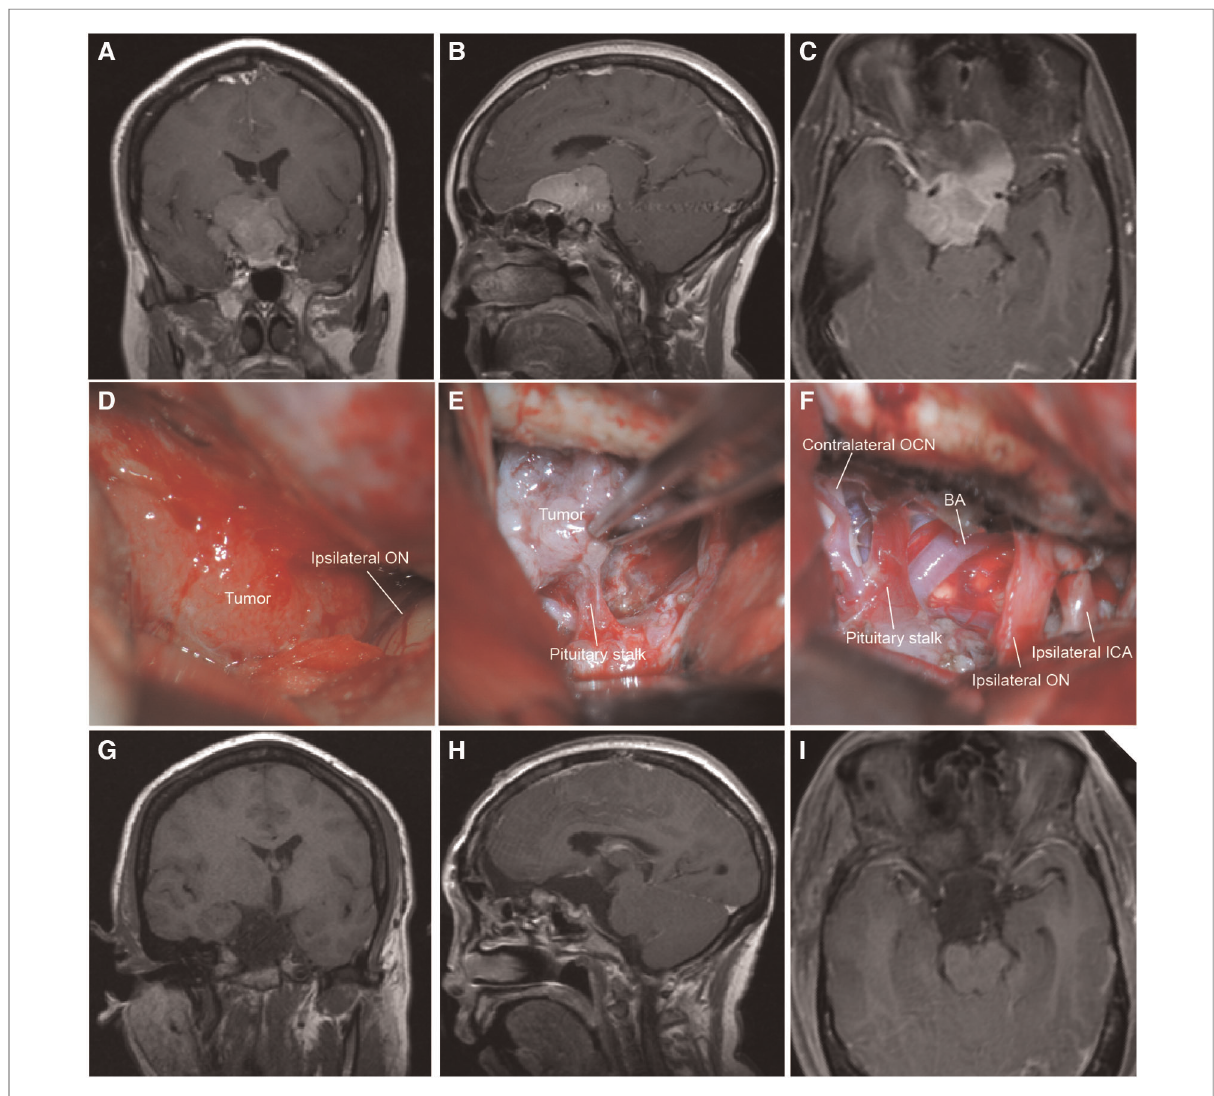
FIGURE 2 The MRI and intraoperative view of a patient operated with the unilateral subfrontal approach. ( A – C ) Preoperative T1-weighted MRI scan showing the giant TSM (maximal diameter=4.4 cm) extended lateral to the ICA and encased neurovascular structures of the suprasellar region. (D,E ) Intraoperative microscopic view showing the tumor through the right bilateral subfrontal approach. The ipsilateral optic nerve was displaced laterally and the pituitary was encased by the tumor. ( F ) Intraoperative microscopic view after total tumor resection. The ipsilateral ICA and optic nerve were preserved. ( G – I ) Postoperative T1-weighted MRI scan con fi rming total tumor removal. BA, basilar artery; OCN, oculomotor nerve; ICA, internal carotid